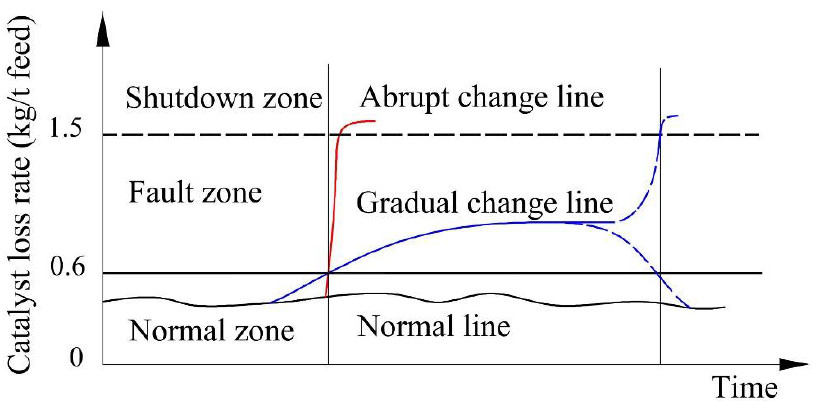
Figure 5. Time-varying characteristics of catalyst loss rate.